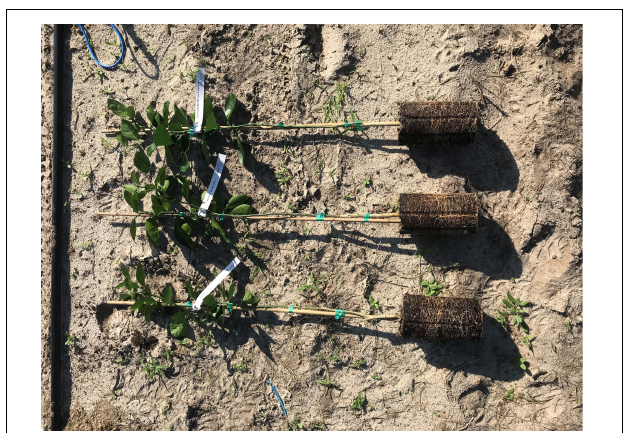
FIGURE 1 | Valencia sweet orange nursery trees at planting time on US-942 rootstock propagated by seed (top), tissue culture (center), and stem cuttings (bottom). Rootstock propagation type appears to have little effect on citrus rootstock performance.